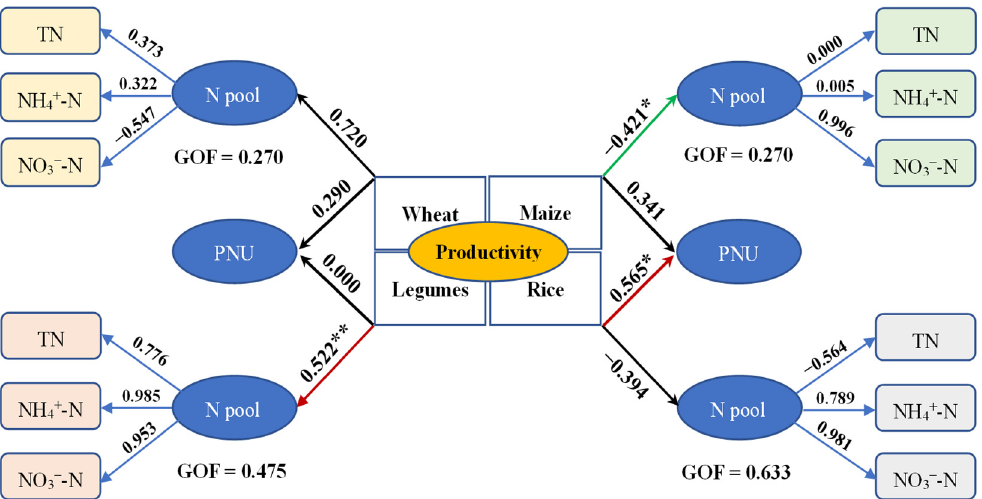
Figure 4. Partial least squares (PLS) path analysis results on the direct and indirect effects of soil N pool (soil total N: TN; ammonium N: NH 4+ -N; and nitrate N: NO 3 − -N) and plant N uptake (PNU) on wheat, maize, rice, and legume productivity. Numbers show the path coefficients. Green and solid red paths indicate negative and positive effects (* and ** represent p < 0.05 and 0.01); The PLS path analysis was assessed using the Goodness of Fit statistic (GOF), and the GOF value was 0.270-0.633. the corresponding latent variables with their considered indicators are under the path analysis results. Numbers below the index show the loading scores (the correlation coefficient between the latent variable and its indicators).